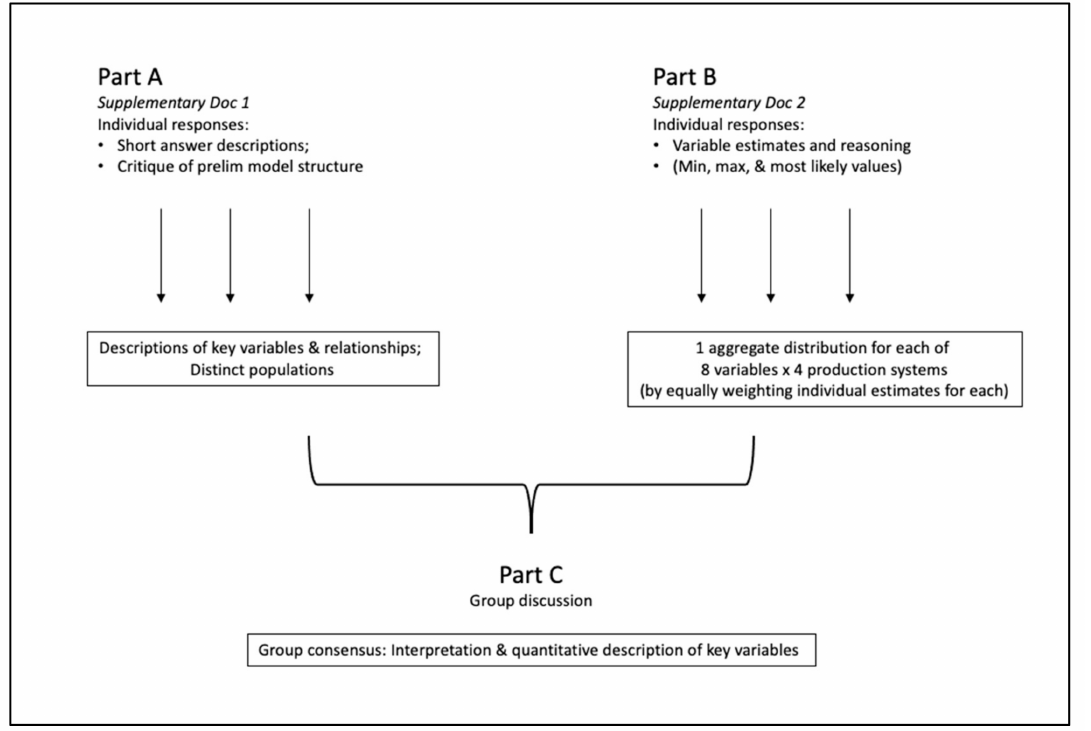
Figure 1. Schematic of the approach used. Parts A, B, and C were carried out separately for Kenya and for Uganda. Parts A and B were individual activities; the individual results were organized and aggregated to present to the group for discussion, revision, and final consensus in Part